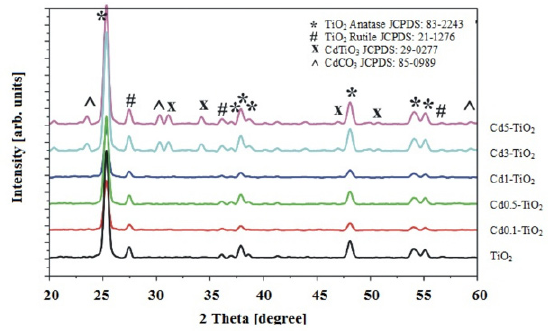
Figure 1. XRD patterns of cadmium doped TiO different doping